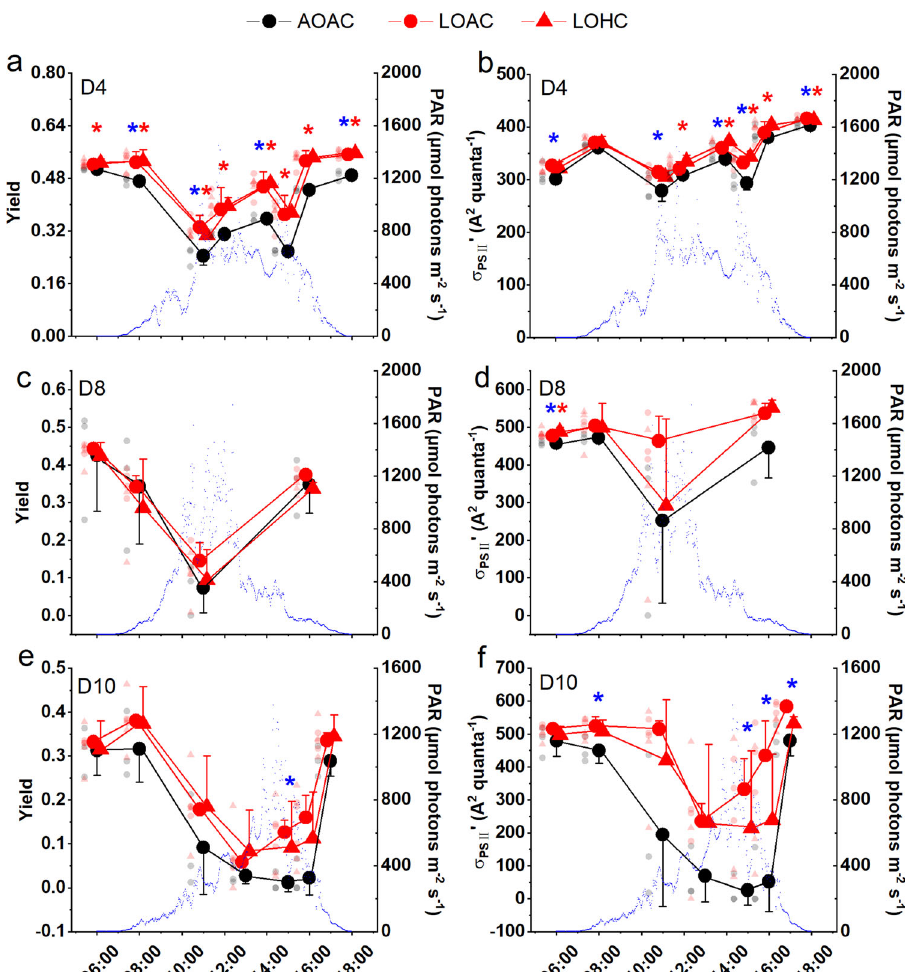
Fig. 3 Diurnal changes in photosystem II (PSII) quantum yield (Yield) and the effective functional absorption cross-section of PSII ( σ PSII ´, A 2 quanta -1 ) of phytoplankton assemblages grown under different O 2 and CO 2 treatments. Effective PSII quantum yield ( a , c , e ) and the effective functional absorption cross-section of PSII ( b , d , f ) at days 4, 8, and 10, respectively. Blue dots represent diel changes in photosynthetically active radiation (PAR, μ mol photons m − 2 s − 1 ) during the experiment. Black symbols represent ambient O μ M) and red symbols low O μ M); circles 2 (AO, ~213 2 (LO, ~57 represent ambient CO 2 (AC, ~13 μ M); triangles represent high CO 2 (HC, ~27 μ M). Detailed information for the mesocosms experimental features are given in Supplementary Figs. 1 and 2. The values are the means and the error bars represent standard deviations of independent biological replicates ( n = 3 mesocosms). Light-colored symbols are individual data corresponding to the treatments. Blue * and red * indicate signi fi cant differences ( P < 0.05, LSD test or Games – Howell test) caused by low O 2 under ambient (LOAC) and elevated CO 2 levels (LOHC), respectively, compared to the control treatment